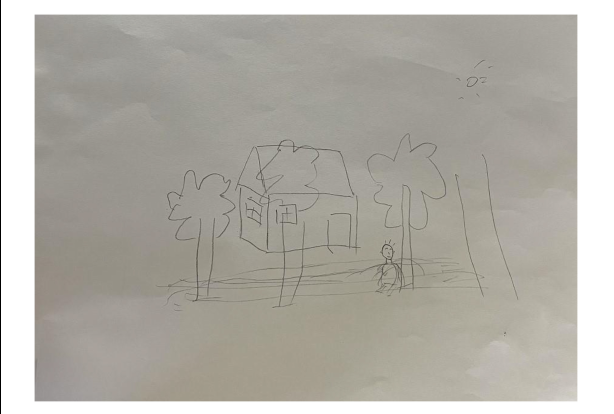
FIGURE 5 | A picture drawn by subject A4 who had state depression.